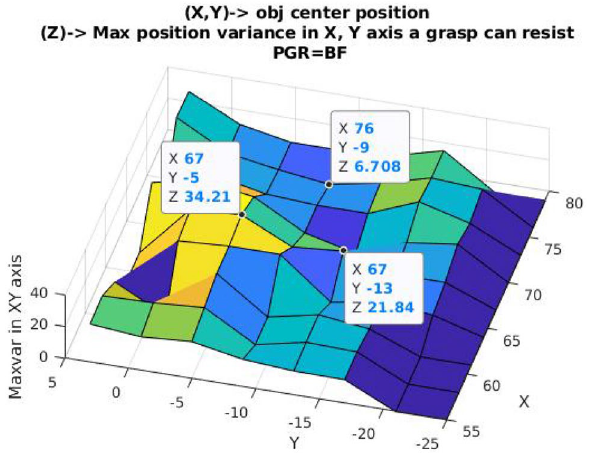
Fig. 9 Robustness to position uncertainty for each (X,Y) positions of the sphere